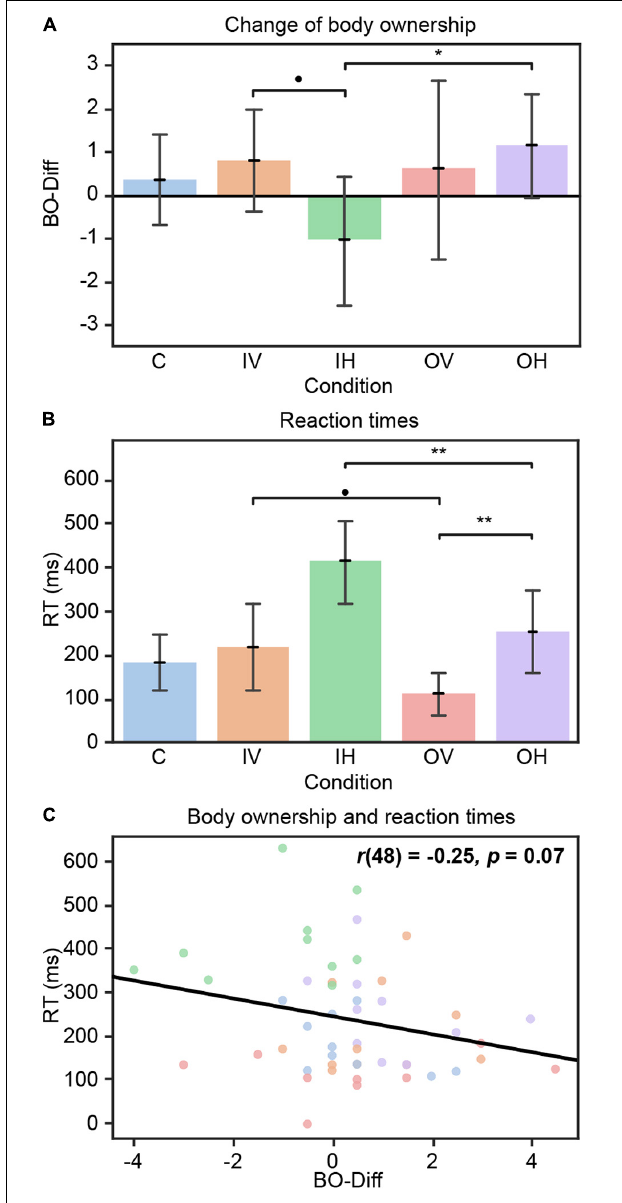
FIGURE 3 | Results Block 1. (A) Change of body ownership from baseline to after Task 1 (BO-Diff) per condition. Positive values indicate an increase in subjective body ownership. (B) Mean reaction times over all trials of Task 1 per condition. The participant’s mean baseline value (from Baseline task)